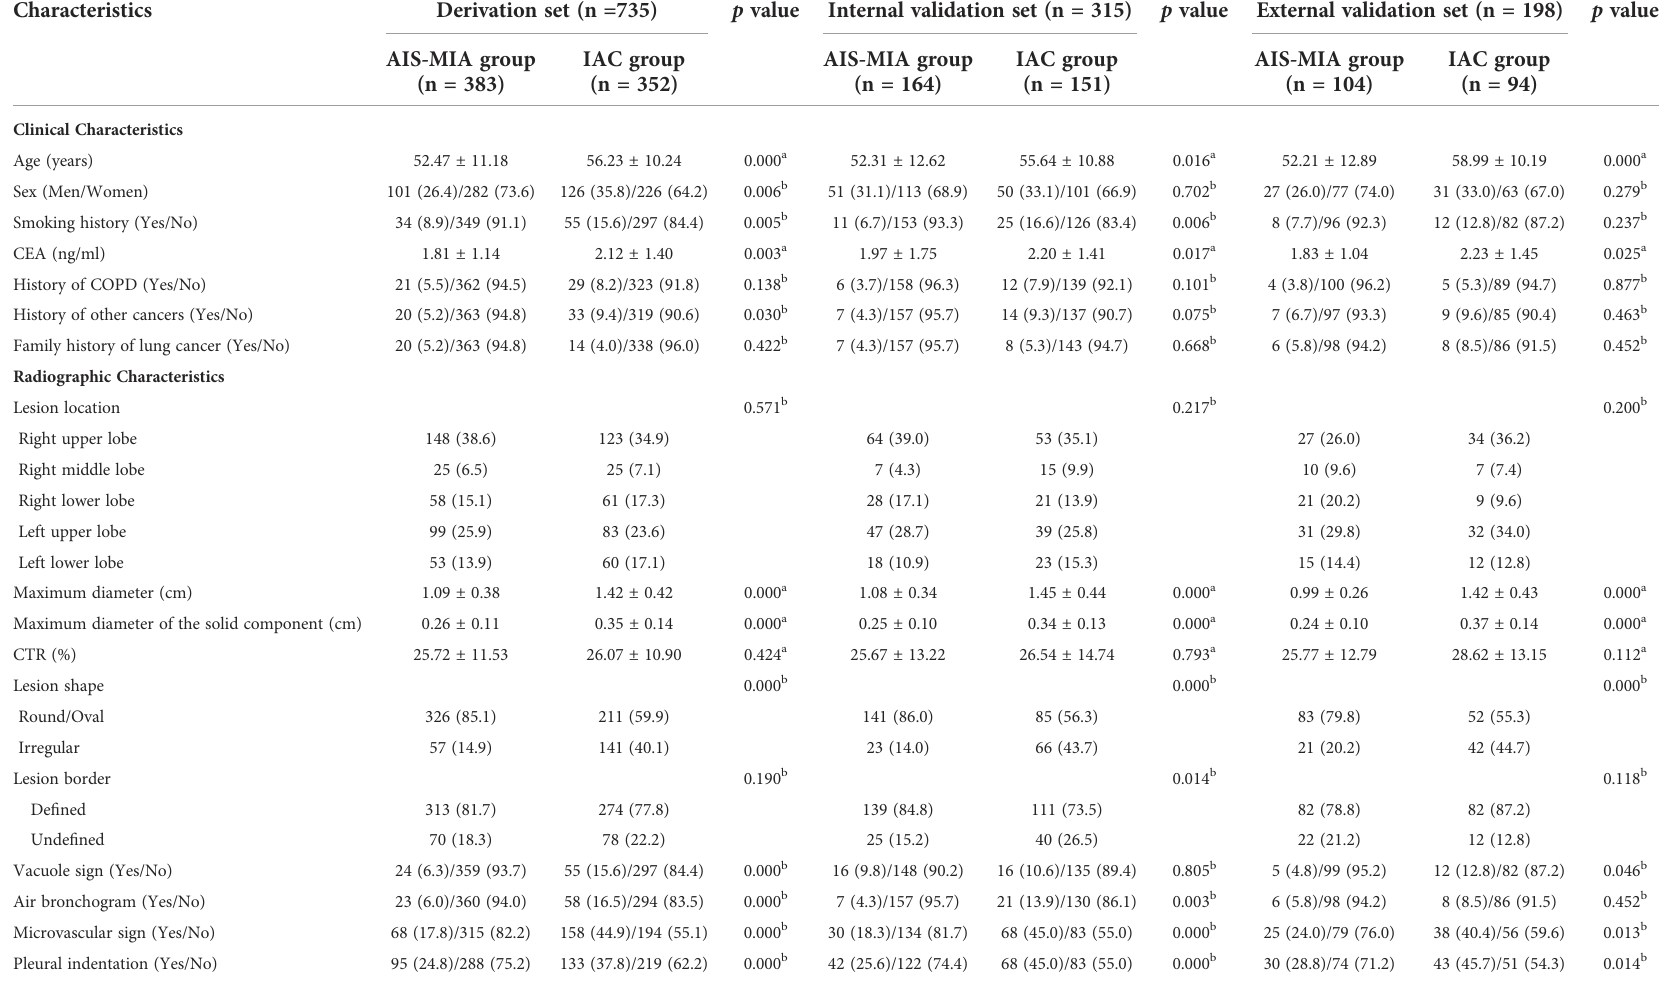
TABLE 2 Comparison on the clinical and radiographic characteristics between AIS-MIA and IAC in the derivation, internal validation, and external validation sets.